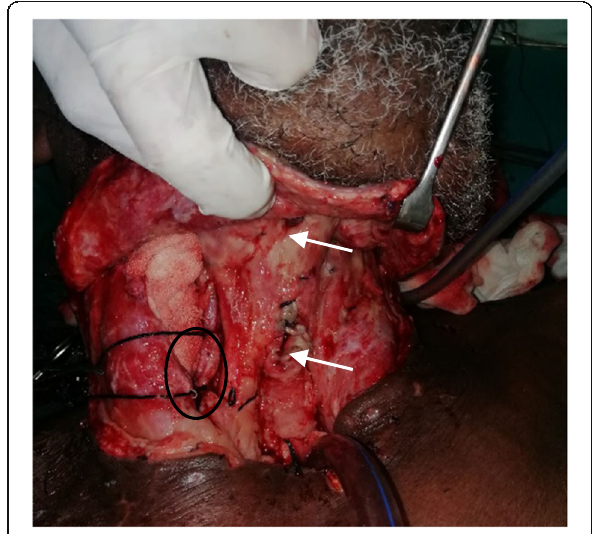
Fig. 5 CT neck with oral contrast of patient G showed leakage of the contrast outside the